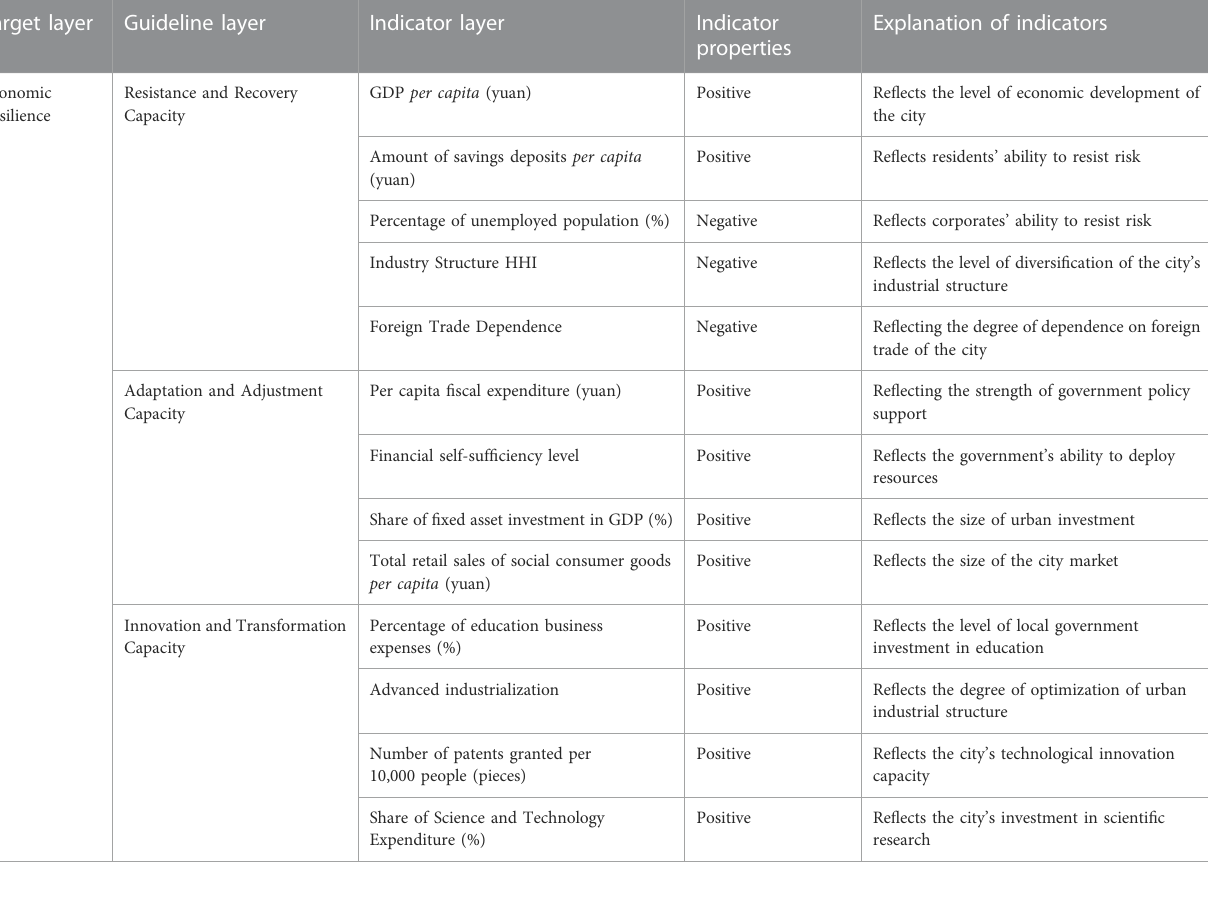
TABLE 1 Comprehensive evaluation index system of economic